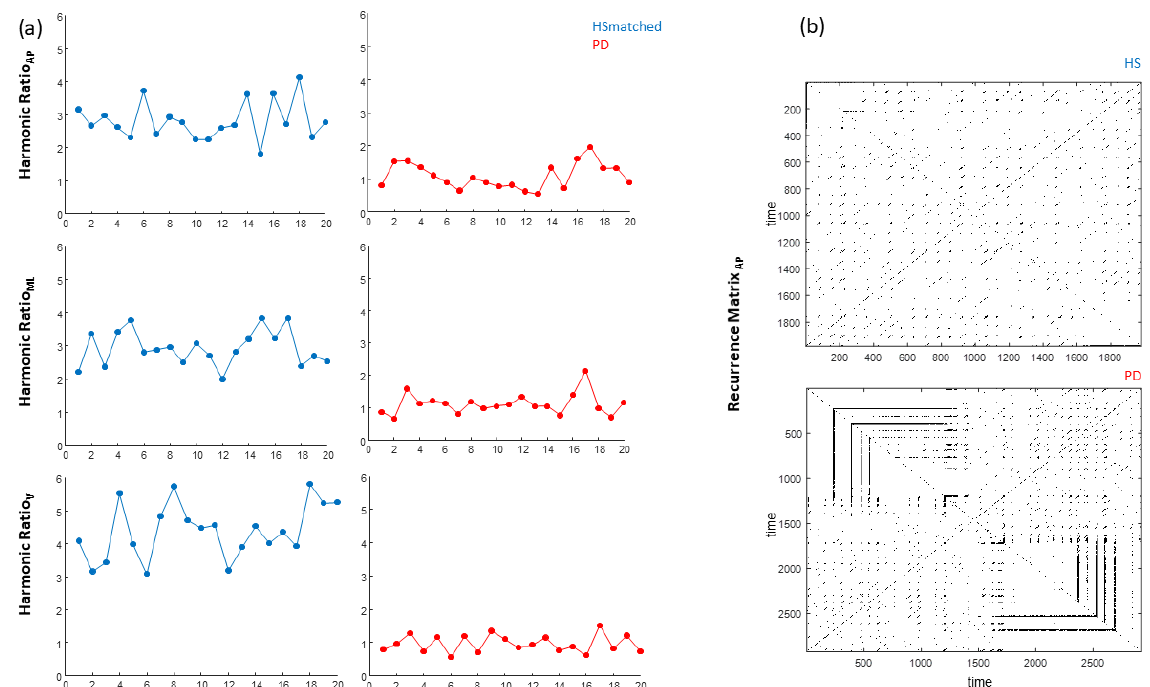
Figure 2. ( a ) Graphical representation of the Harmonic Ratios in the antero-posterior, medio-lateral, and vertical directions of a representative age-and-speed-matched healthy subject (blue) and a subject with PD at Hoehn and Yahr stage = 3 (red); ( b ) recurrence matrices in the antero-posterior direction of the same representative subjects. Table 1. Comparison of the gait stability indexes between subjects with PD and HS matched